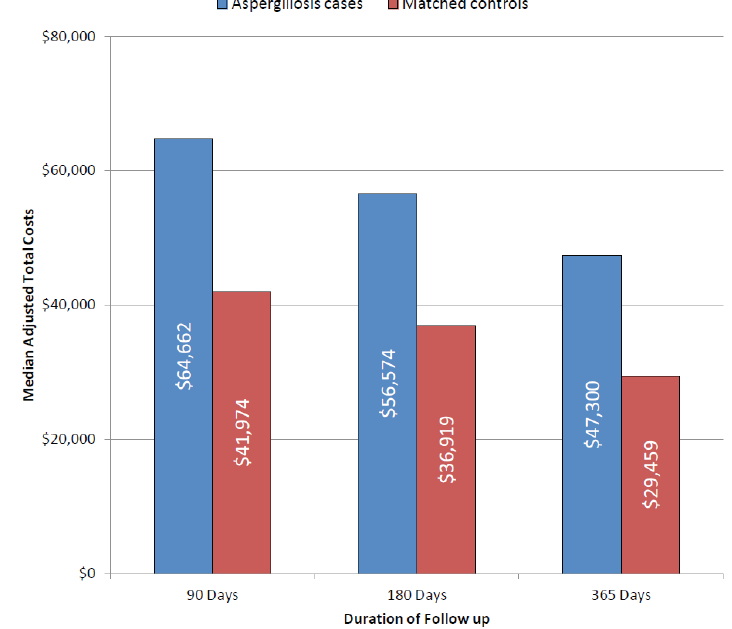
Figure 1. Total Healthcare Costs Adjusted for Covariates and Length of Follow-up Probability